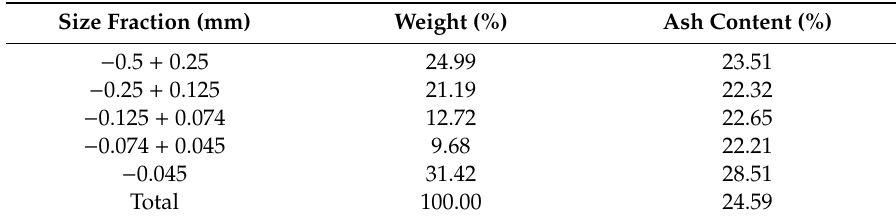
Table 2. Particle size distribution of the coal